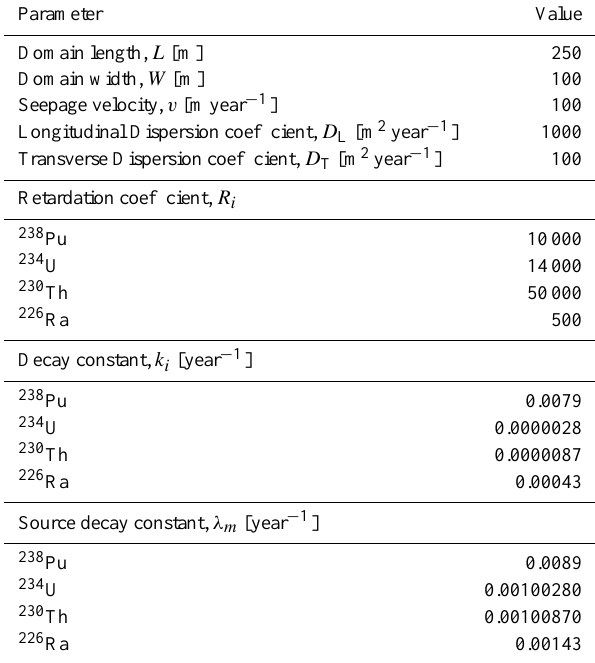
Table 1. Transport parameters used for convergence test example 1 involving the four-species radionuclide decay chain problem used by van Genuchten